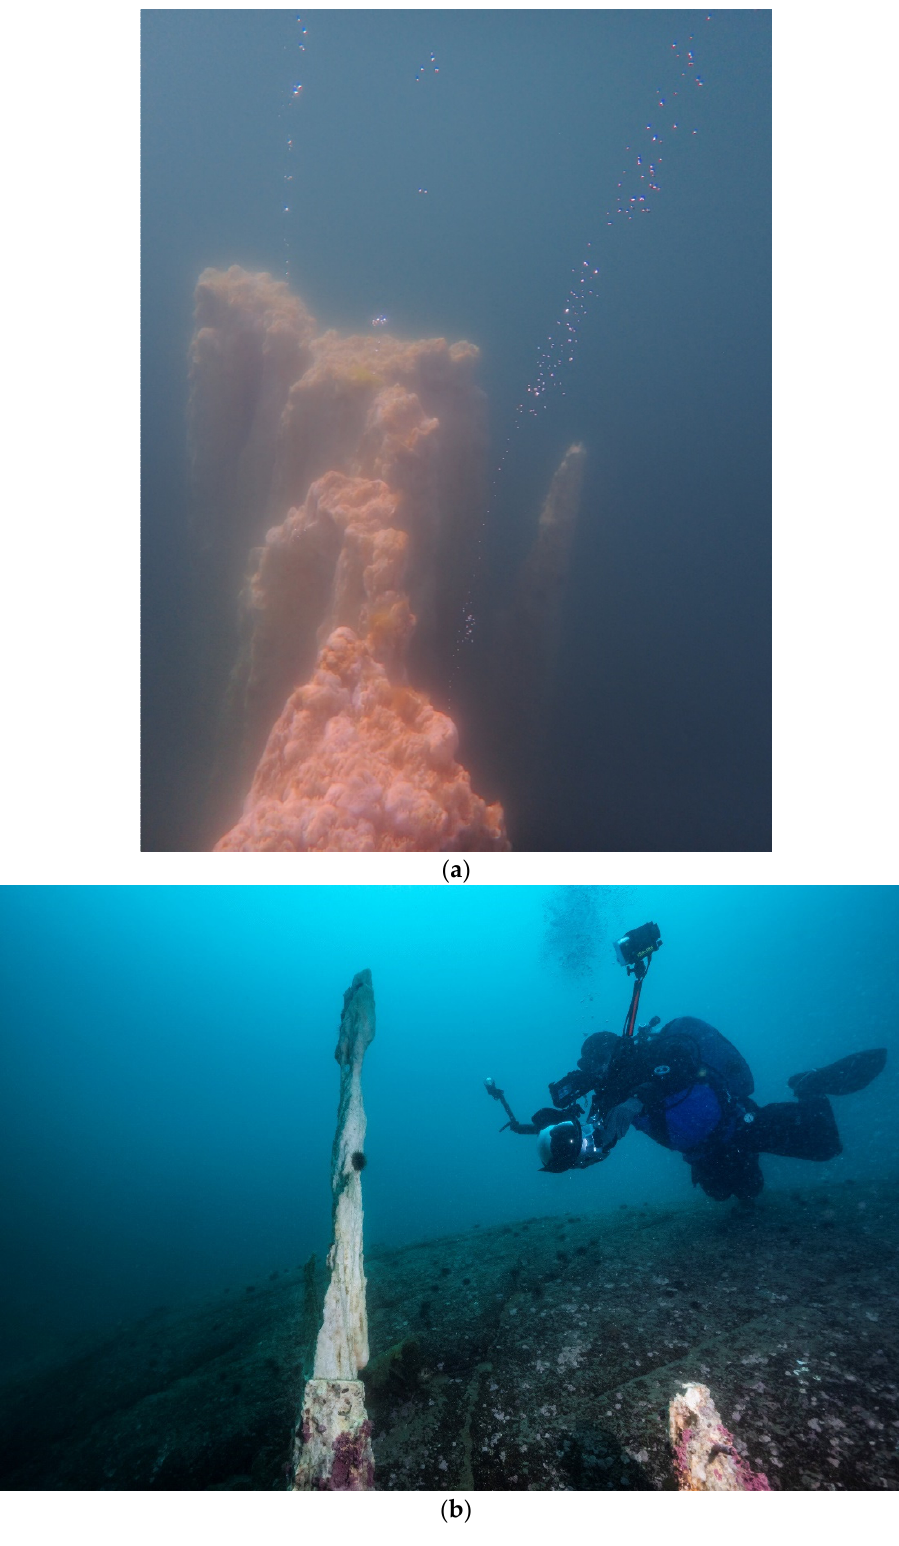
Figure 4. ( a ) Photo showing the air bubbles and groundwater escaping from the columns in 2022, and ( b ) the new growth of ikaite on a column that was last cut in 1997. Photo credits: Bengt Liljebladh ( a ) and Uli Kunz ( b ).